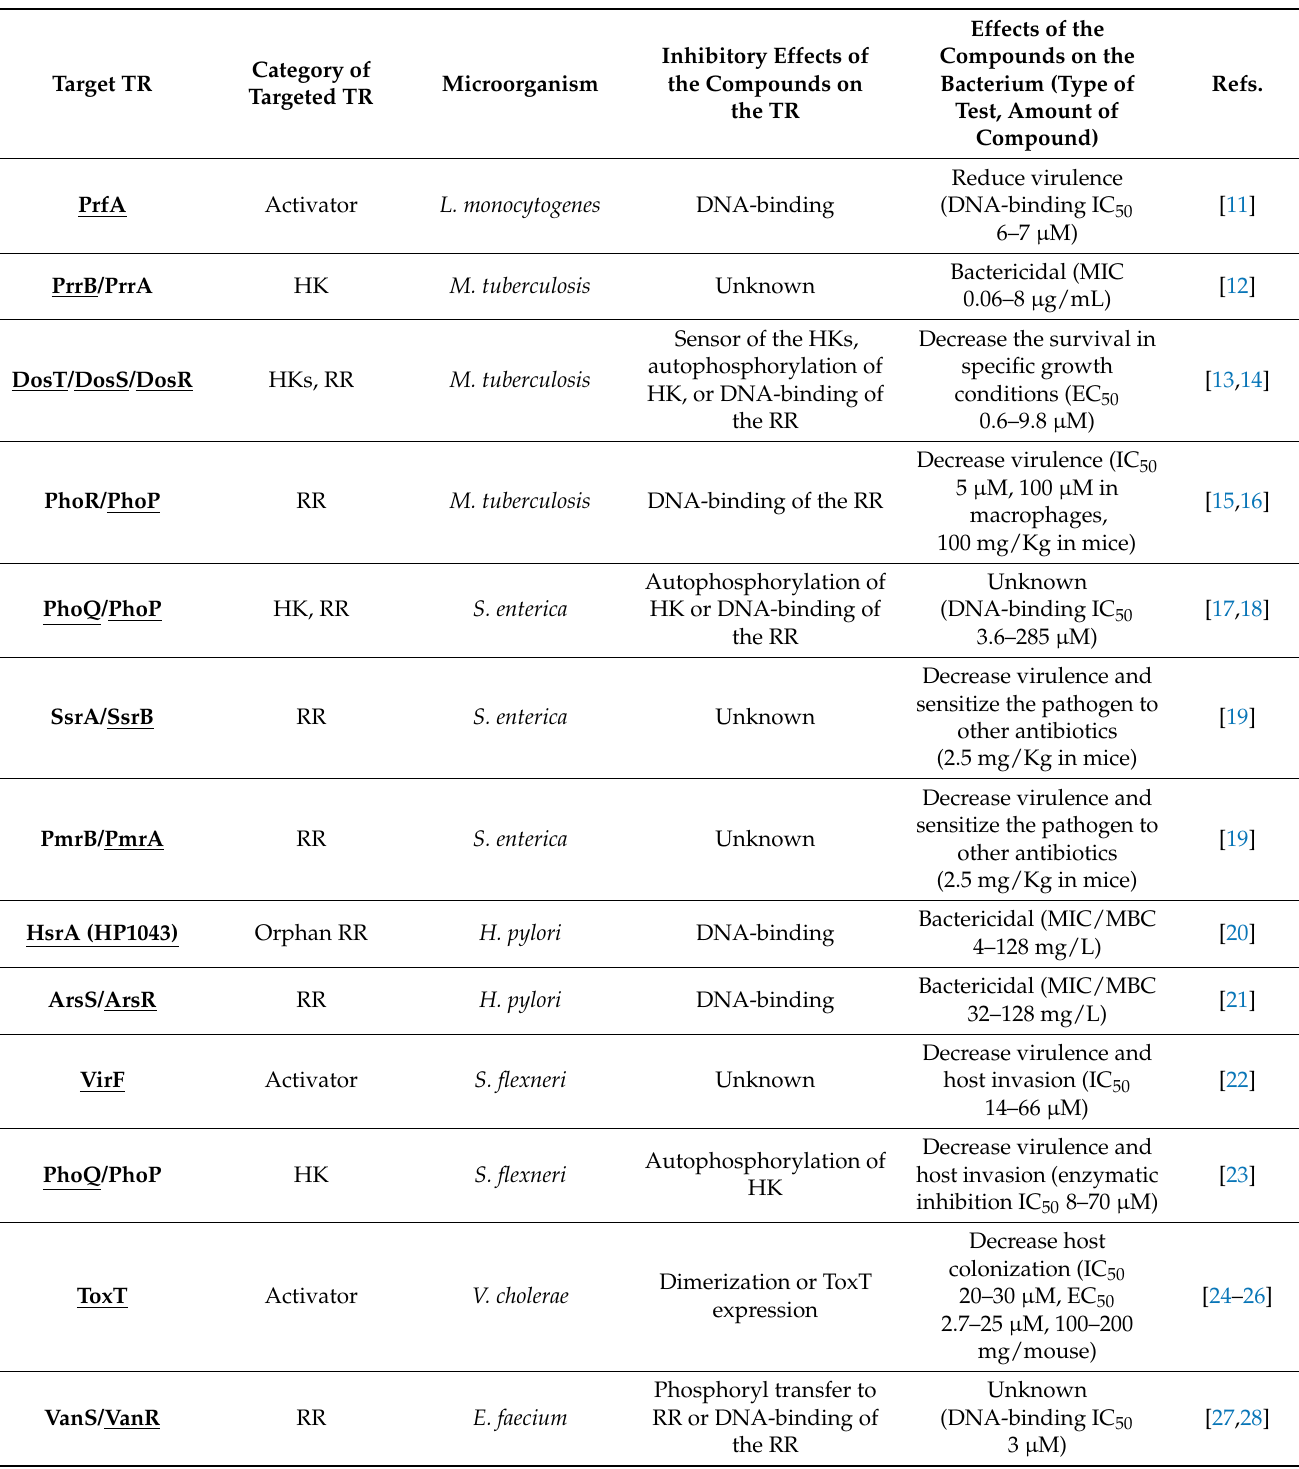
Table 1. List of target TRs responding to inhibitory compounds in several